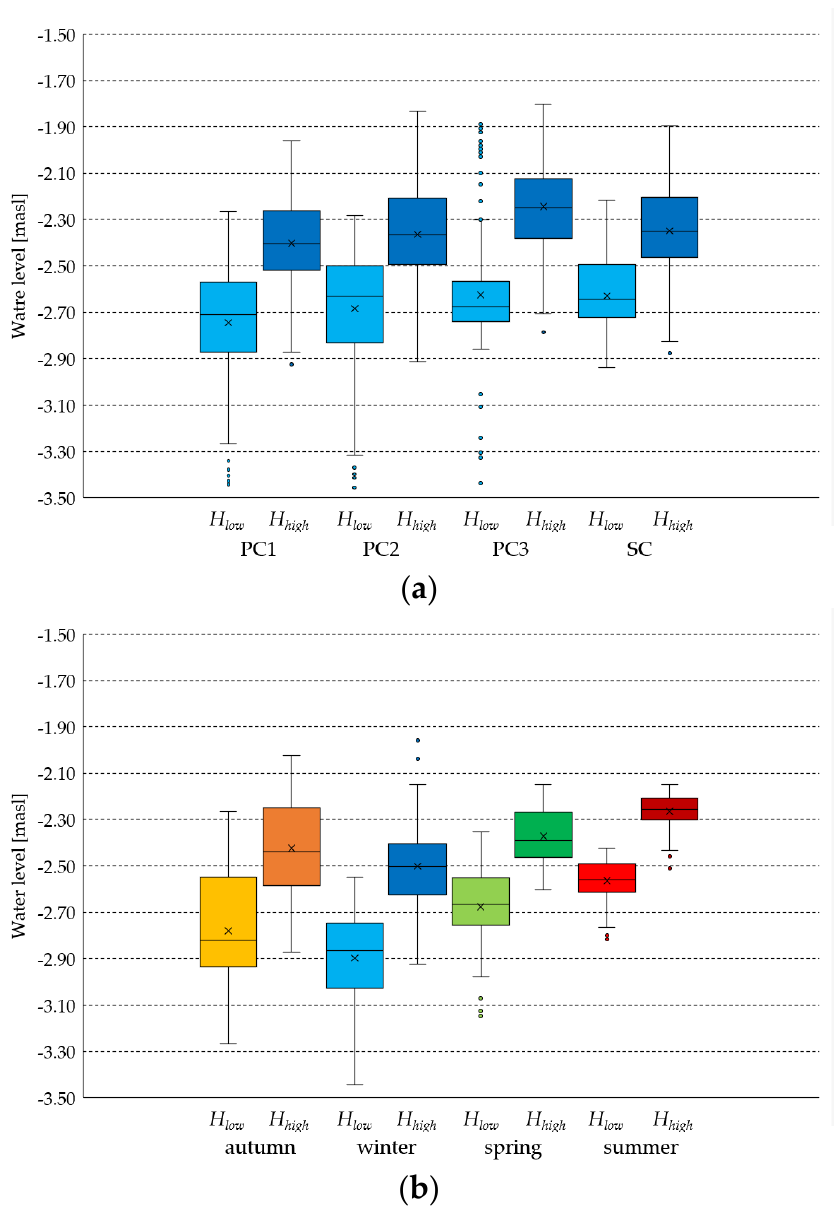
Figure 4. Boxplot of water level fluctuations at PC1, PC2, PC3, and SC ( a ) and water level fluctuations at PC1 across seasons ( b ). Data is separately presented for low peaks and high peaks, from left to right for each station and season, respectively. Symbol “x” marks mean value, strikethrough marks median value, and circles represent potential outliers.